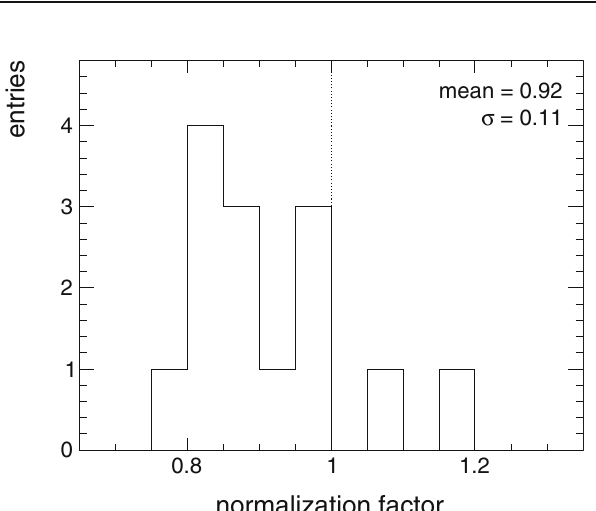
Fig. 4 Normalization factors introduced for the spectrometer experi-